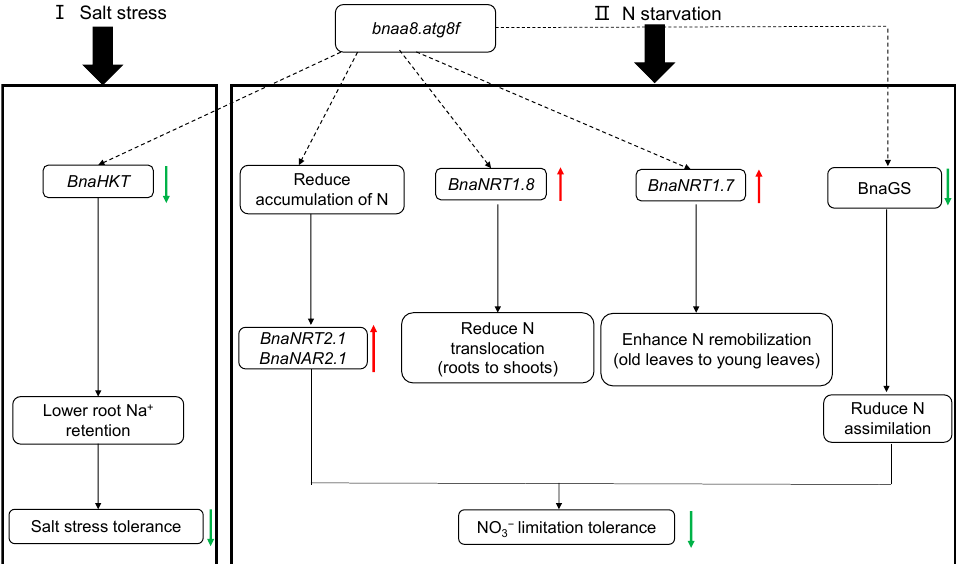
Figure 8. A proposed strategy model for the BnaA8.ATG8F -mediated regulation of nitrogen limitation adaptation and salt stress resistance in allotetraploid rapeseed. The dashed lines indicate potential or indirect regulation, and the red and green solid lines denote the up-regulation and down-regulation of gene expression by N starvation and salt stress.